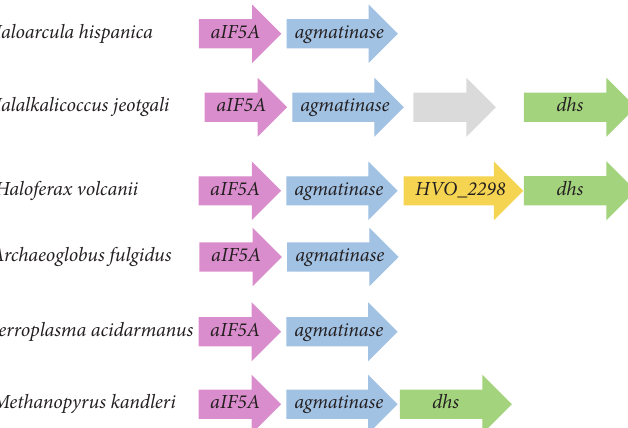
Figure 2: HVO 2299 of Hfx. volcanii clusters with aIF5A . Physical gene clustering links genes encoding agmatinase, DHS, and aIF5A in Euryarchaeota. In pink, aIF5A ( HVO 2300 in Hfx. volcanii ); in blue, agmatinase ( HVO 2299 in Hfx. volcanii); in yellow, gene encoding HVO 2298 ; DHS ( HVO 2297 in Hfx. volcanii ). Arrows represent the genes. Physical clustering was analyzed on the STRING